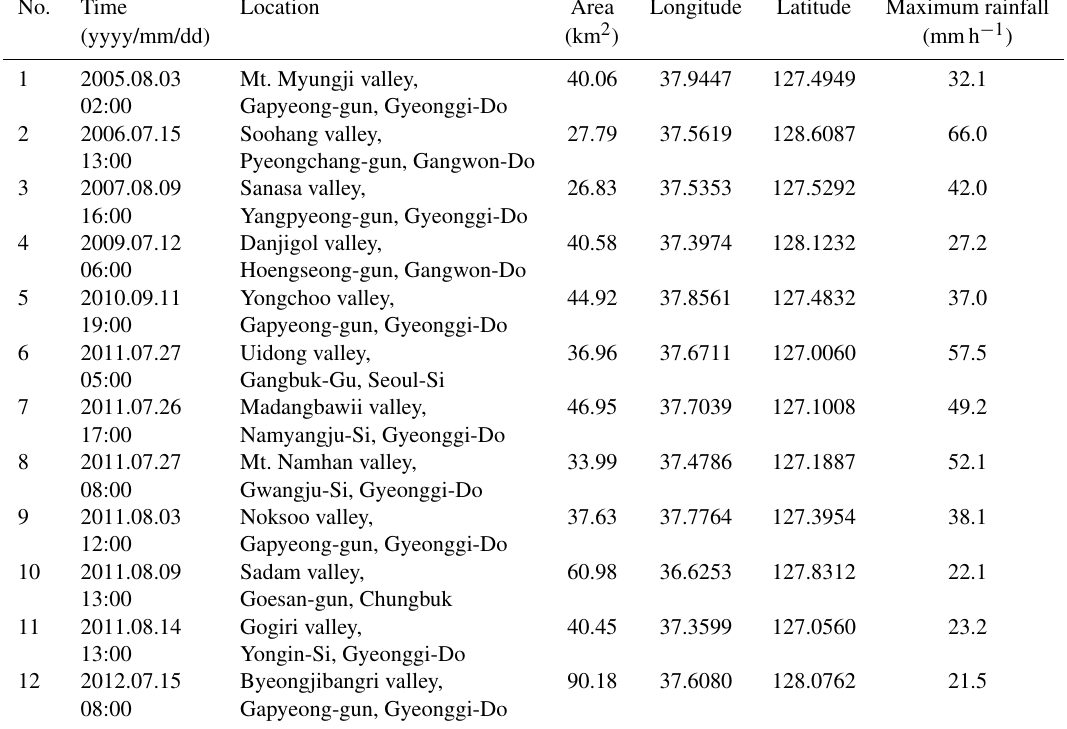
Table 1. Flash flood records collected in the Han River basin.